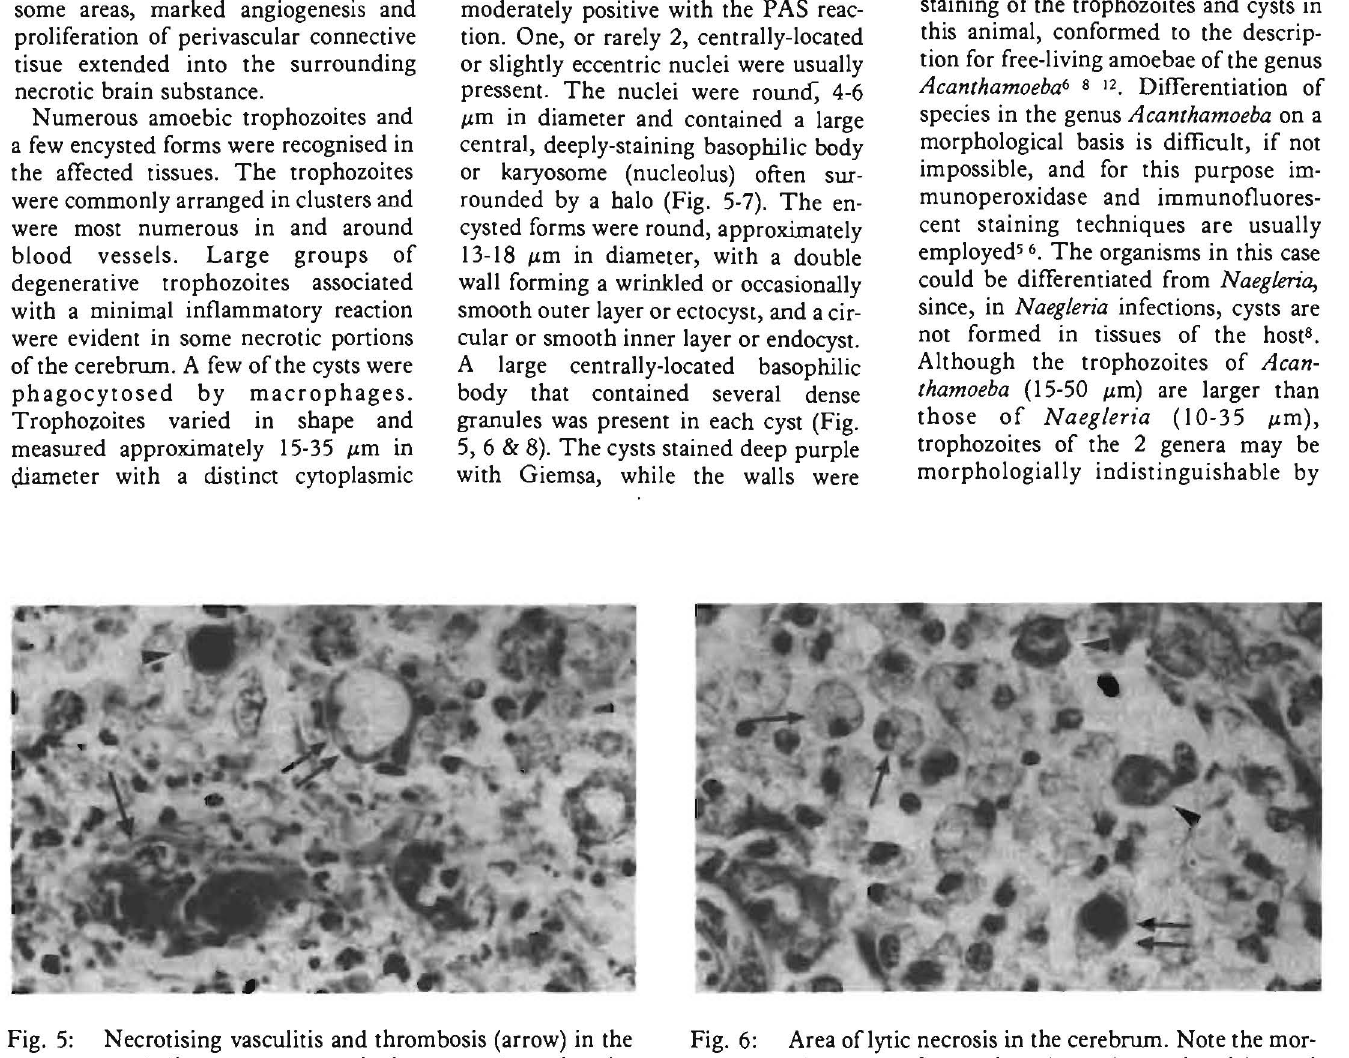
Area oflytic necrosis in the cerebrum. Note the mor phology of trophozoites (arrowheads) and macrophages (single arrows). A cyst is also evident (double arrows). HE X 500